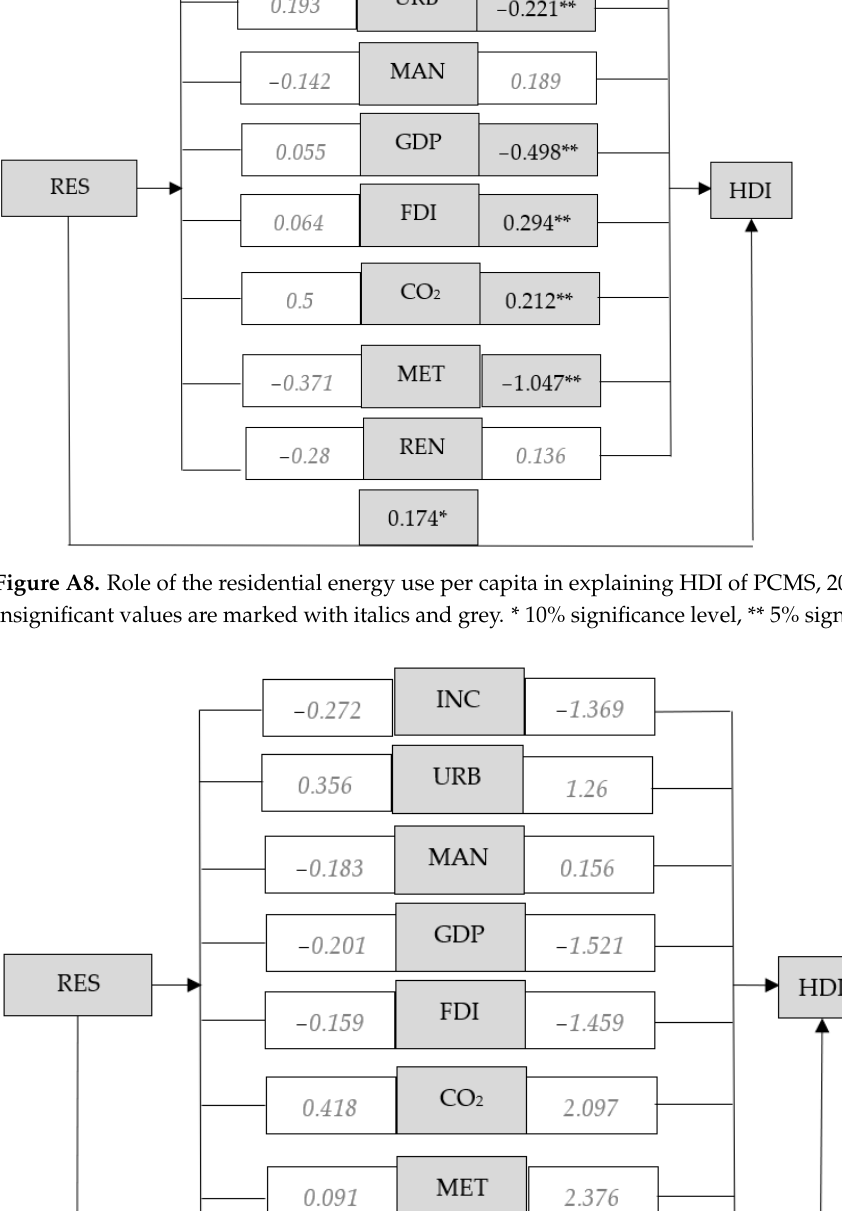
Figure A7. Role of the residential energy use per capita in explaining HDI of PCMS, 2000. Note: the insignificant values are marked with italics and grey.